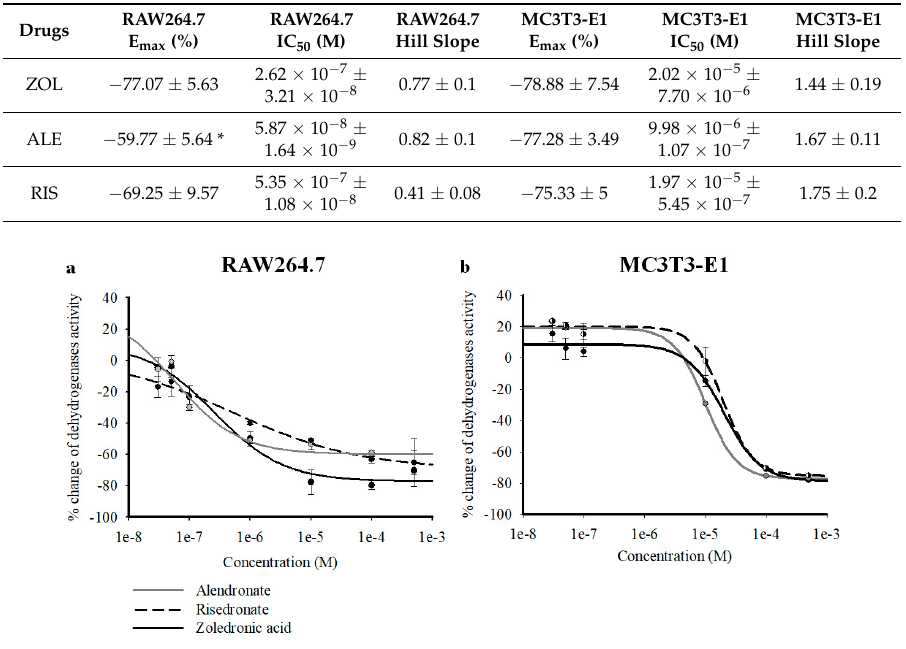
Figure 1. Percentage changes of dehydrogenase activity vs. alendronate (ALE), risedronate (RIS), and zoledronic acid (ZOL) concentrations in murine preosteoclast-like cells RAW264.7, and in murine preosteoblast-like cells MC3T3-E1. Cell dehydrogenase activity was measured using a colorimetric assay (Cell Counting Kit-8) after the incubation of the cells throughout 72 h. Each experimental point represents the mean ± SEM of at least three replicates. Data were fitted using the Hill equation (SigmaPlot 10). All three compounds were capable of causing a significant concentration-dependent reduction of cell dehydrogenase activity, with different efficacy and potency in ( a ) RAW264.7 cells and ( b ) MC3T3-E1 cells. The ZOL and ALE concentration–response relationships were shifted to the left on the log concentration axis in RAW264.7 cells. ZOL was more effective than ALE and RIS in reducing cell proliferation in RAW264.7 cells. All bisphosphonates (BPs) were capable of increasing cell dehydrogenase activity on MC3T3-E1 in the nanomolar concentration range. Table 1. Fitting parameters of the concentration–response relationships of percentage reduction of dehydrogenase activity vs. BP concentration in preosteoclast RAW264.7 and preosteoblast MC3T3- E1. Values are expressed as the mean ± SEM of at least three replicates, as evaluated by using SigmaPlot 10. Data significantly different vs ZOL data *.